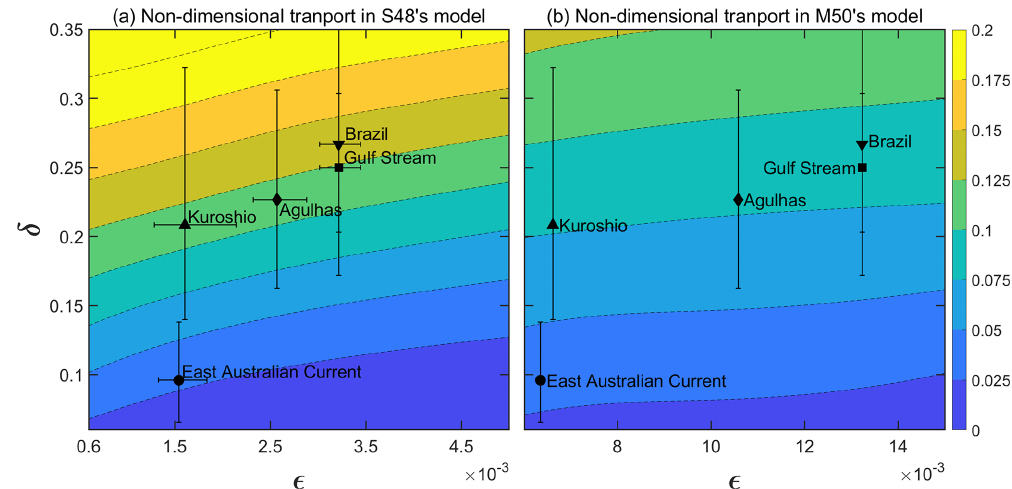
Figure 4. The non-dimensional transport of the western boundary current (WBC) as a function of (cid:15) and δ in (a) S48’s model and (b) M50’s model. Contours depicted are obtained from numerical simulations for fixed L x = 10000km, β = 2 × 10 − 11 m − 1 s − 1 , and by varying r between 1 / 100 and 1 / 10d − 1 in S48’s model (a) and µ = 10000m 2 s − 1 in M50’s model (b) . The different WBCs in the world ocean are depicted with different symbols, and the error bars denote the possible variability of parameters that can occur because of an error in estimating the zonal and meridional extents of the basins that contain the WBC. The width of each of the WBCs, (cid:15) , is estimated using r = 1 / 30d − 1 (a) and µ = 10000m 2 s − 1 (b) and β = 2 × 10 − 11 m − 1 s − 1 . The zonal extent, L x , of the basin containing the particular WBC is given in Table C1. The error in (cid:15) is not accounted for in (b) because the WBC’s transport in M50’s model is (nearly) independent of (cid:15) . The East Australian Current’s non-dimensional transport, as calculated from both S48’s and M50’s models, is less than those of the other four WBCs. The uncertainty in δ for the Brazil Current extends up to 0.375 in both models; the contours have been restricted to better resolve the boundary currents. The range between which the non-dimensional transport varies is similar in both the